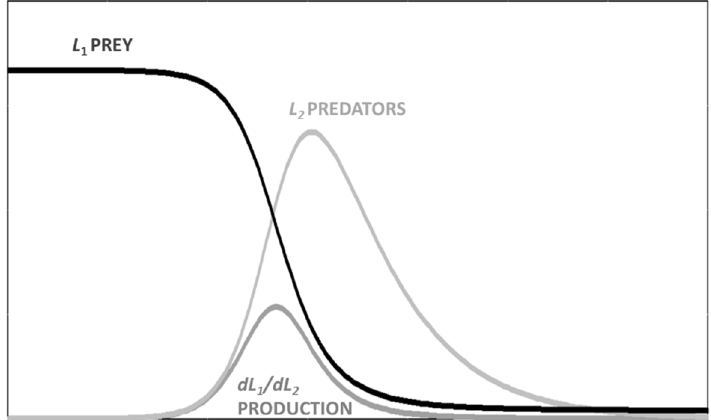
Figure 4. Single-cycle two-stock model (SCLV): Resources = L 1 ; Capital = L 2 ; Production = dL 1 / dt . The SCLV model has a stable attractor for L 2 = 0 (extinction of the predators) but not necessarily for L 1 = 0. In the case of an economic system, it means that the resource will not be completely exploited before the capital stock goes to zero.